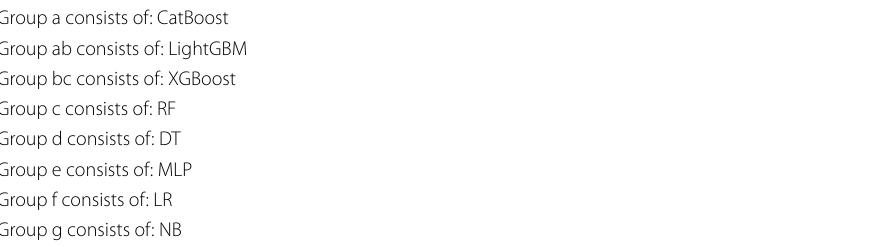
Table 9 HSD test groupings after ANOVA of AUC for the Classifier factor Group a consists of: CatBoost Group ab consists of: LightGBM